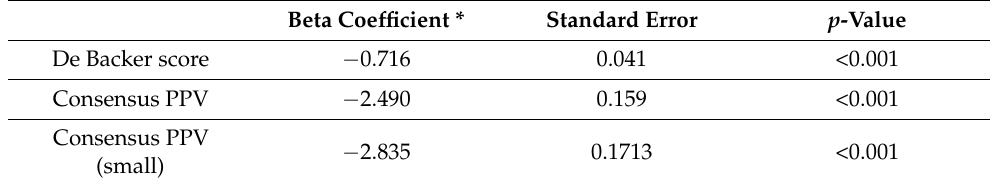
Table 2. Association of suPAR with intraoperative sublingual microcirculatory perfusion. Beta Coefficient